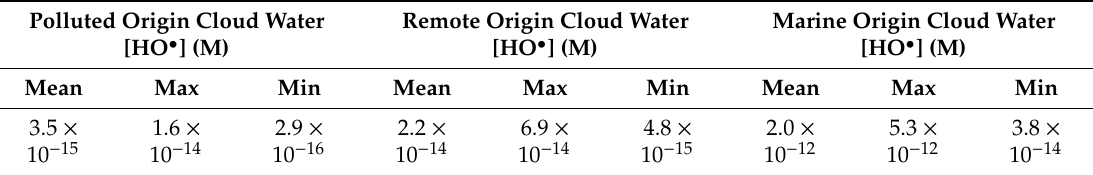
Table 3. Calculated HO • radical concentrations in clouds and deliquescent particles using the CAPRAM 3.0 multiphase mechanism. Mean concentrations are averaged values over three simulation days. Data adapted from Tilgner et al.